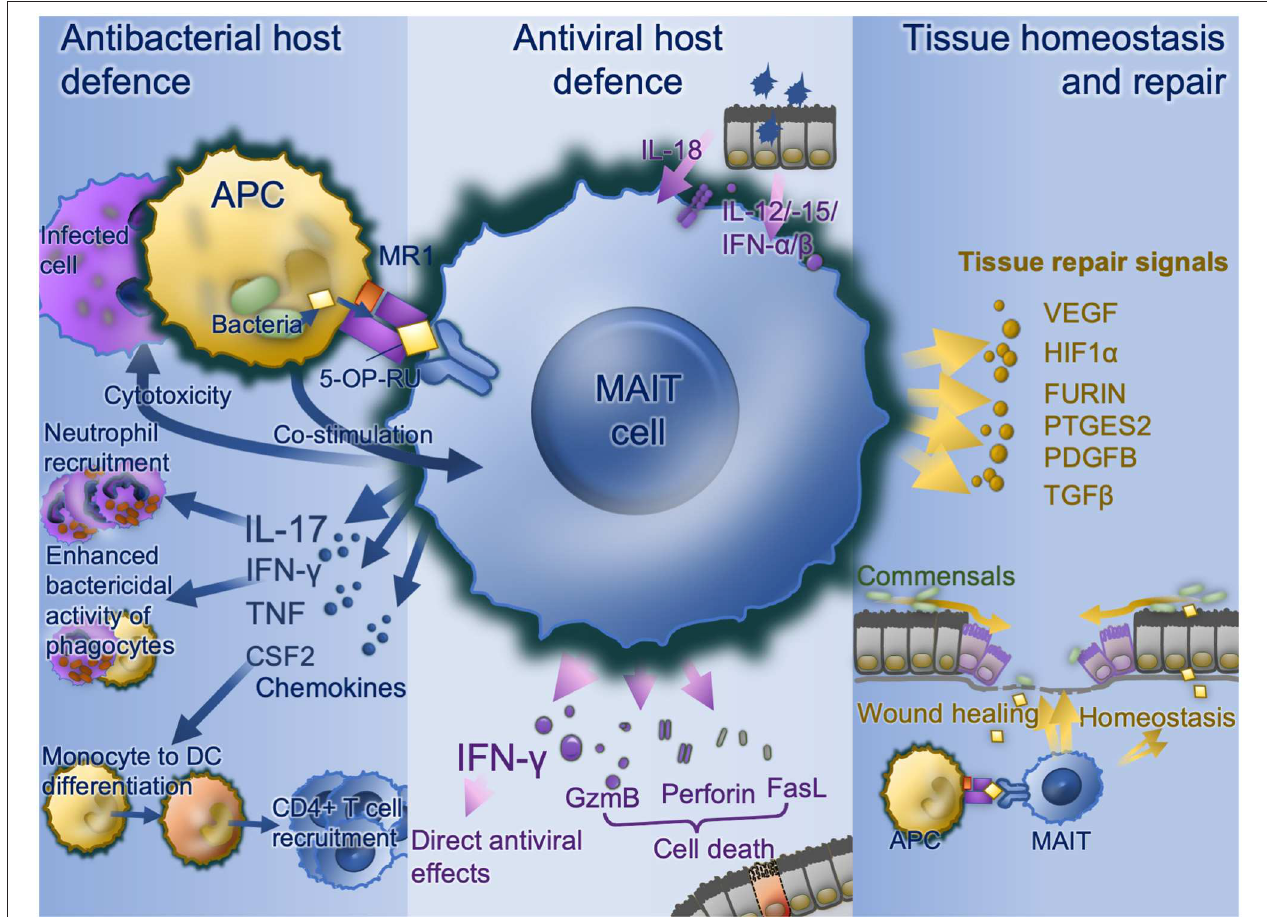
FIGURE 2 | MAIT cell functions. Bacterially-infected cells present MAIT cell ligands on MR1 with co-stimulation and activate MAIT cell antibacterial defense functions including IFN- γ enhancement of antibacterial function in phagocytes, recruitment of neutrophils via IL-17 and differentiation of inflammatory monocytes to DCs in turn driving CD4T cell recruitment. Virally infected cells produce IL-18, IL-12, IL-15, and type I interferons which upregulates IFN- γ with direct antiviral effects as well as direct cytotoxic MAIT cell functions via granzyme B, perforin, and Fas ligand. Commensal derived MAIT cell ligands, in the absence of co-stimulation stimulate MAIT cells to promote tissue homeostasis. Where a mucosal barrier is damaged these signals are enhanced and accompanied by damage signals to drive accelerated tissue repair signals. APC, antigen-presenting cell; CSF2, colony stimulating factor 2 (GM-CSF); DC, dendritic cell; FasL, Fas cell surface death receptor ligand;